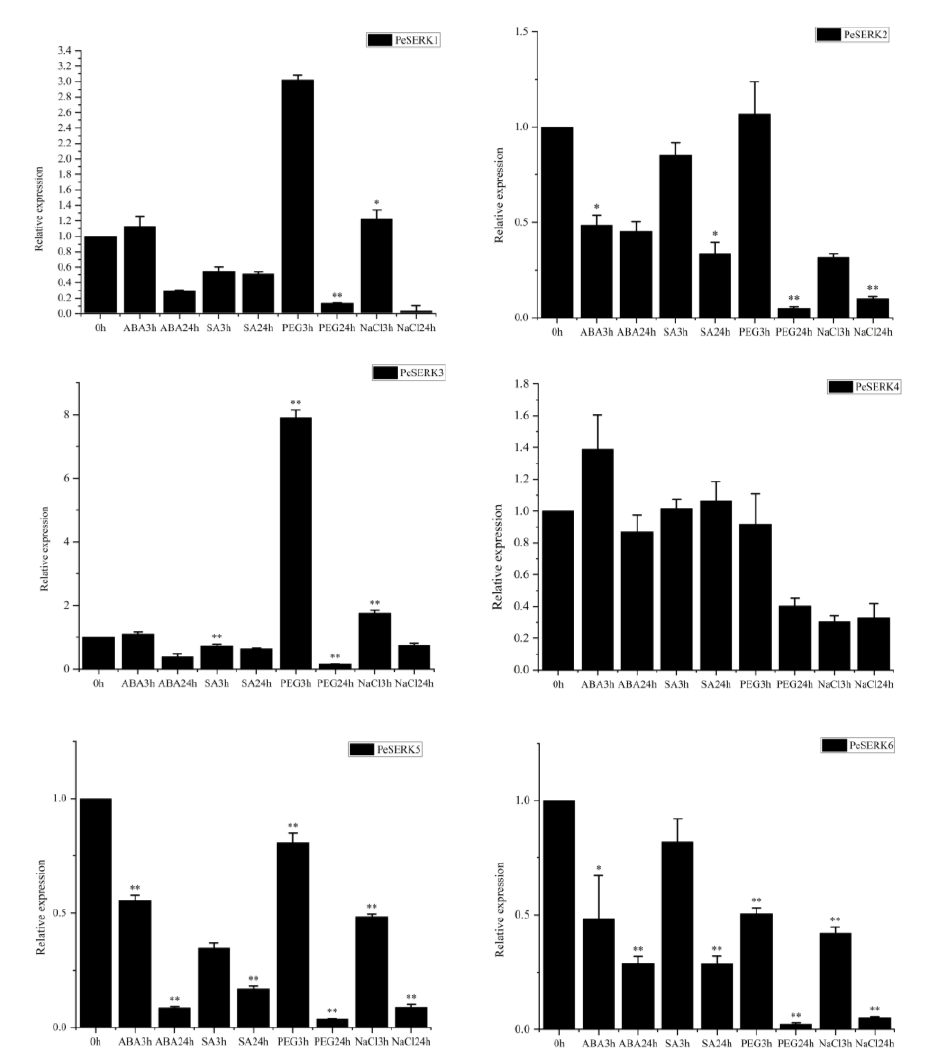
Figure 8. Expression levels of PeSERKs in moso bamboo under abiotic and phytohormone treatment. The expression of NTB was the internal control to standardize the RNA samples for each reaction. Data are the mean ± SE from three samples, * P ≤ 0.05, ** P ≤ 0.01.